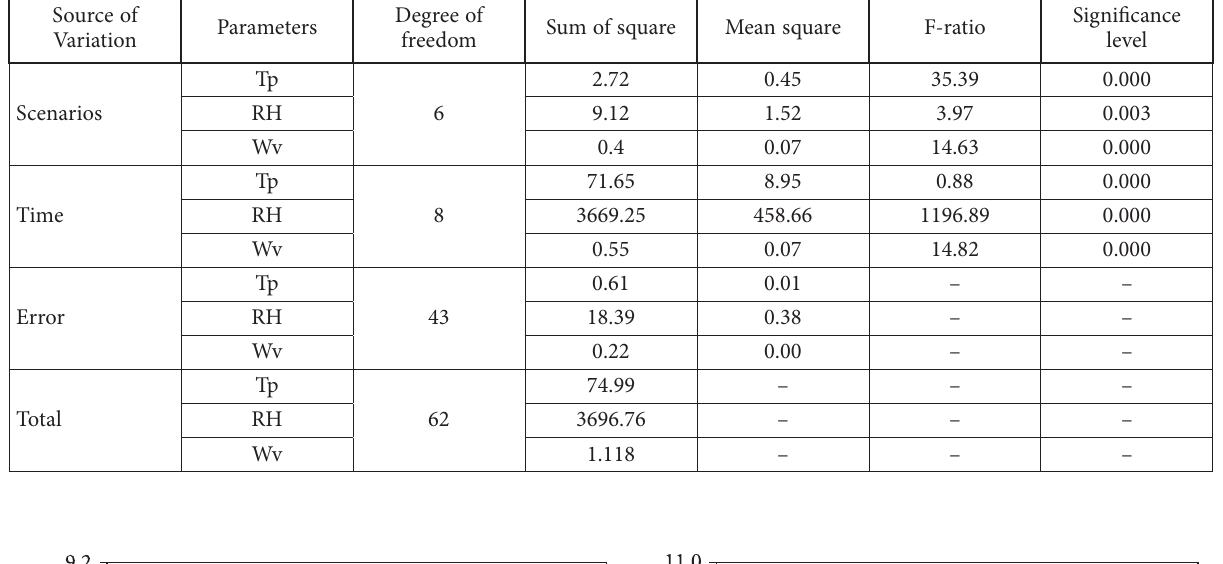
Table 2. Analysis of Variance of weather parameters (Tp, RH and WV) in different scenarios and the time period Source of Variation